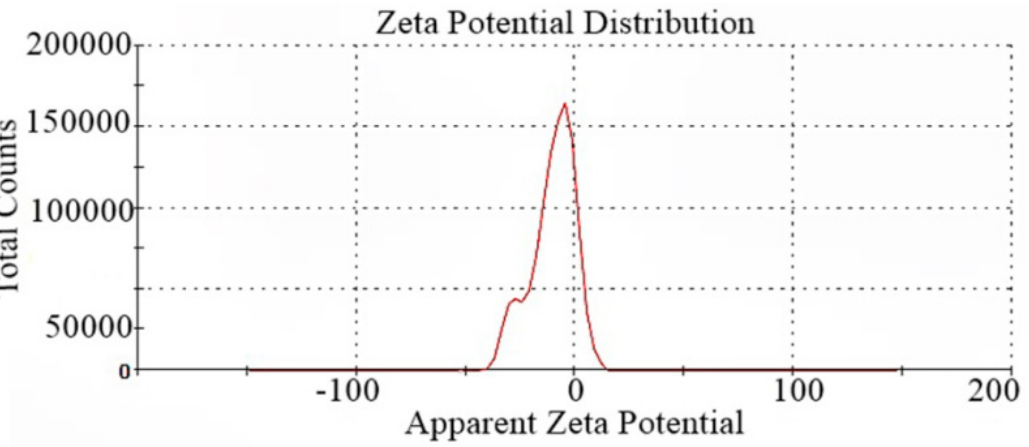
Figure 4. Zeta Potential for SDS/FeSP nanocomposite.